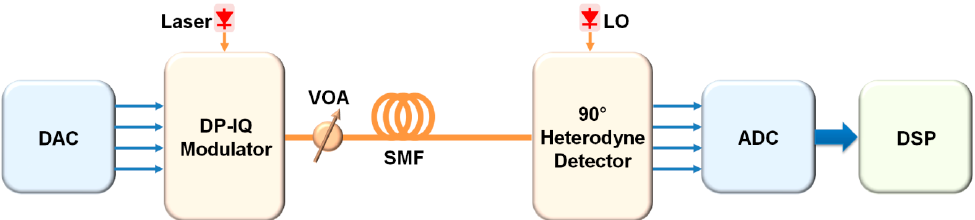
Figure 4. Experimental setup. DAC: digital-to-analog converter, IQ: in-phase (I) and quadrature (Q), VOA: variable optical attenuator, SMF: single-mode fiber, LO: local oscillator, ADC: analog-to-digital converter, DSP: digital signal processing.